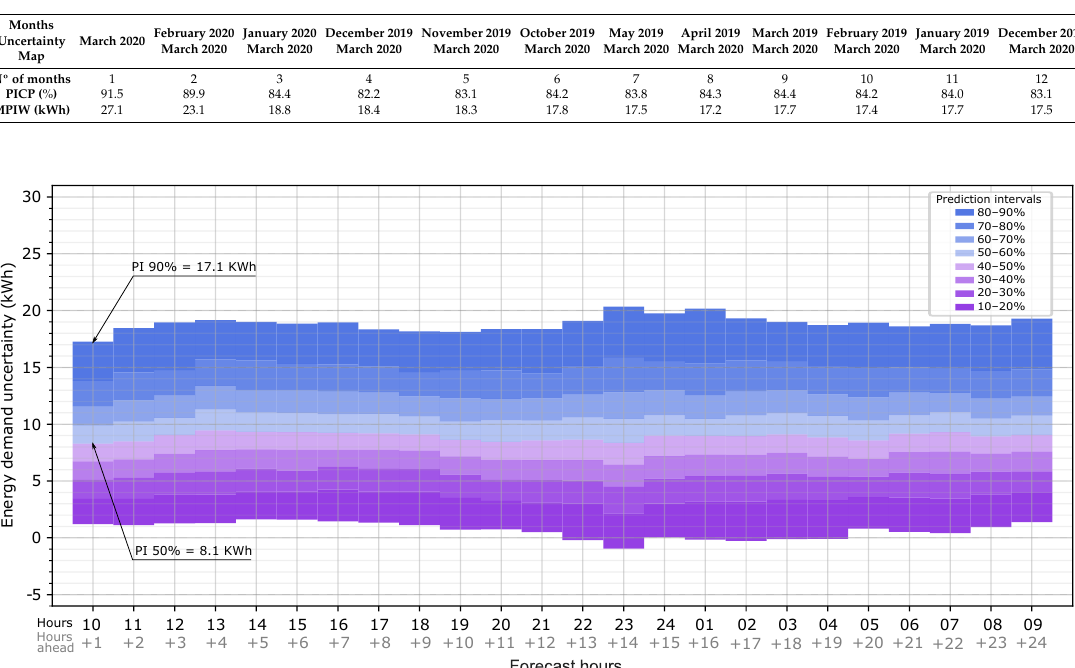
Table 2. Prediction interval coverage probability (PICP) and mean prediction interval width (MPIW) results when using a gradually increasing amount of data for the creation of the uncertainty map.